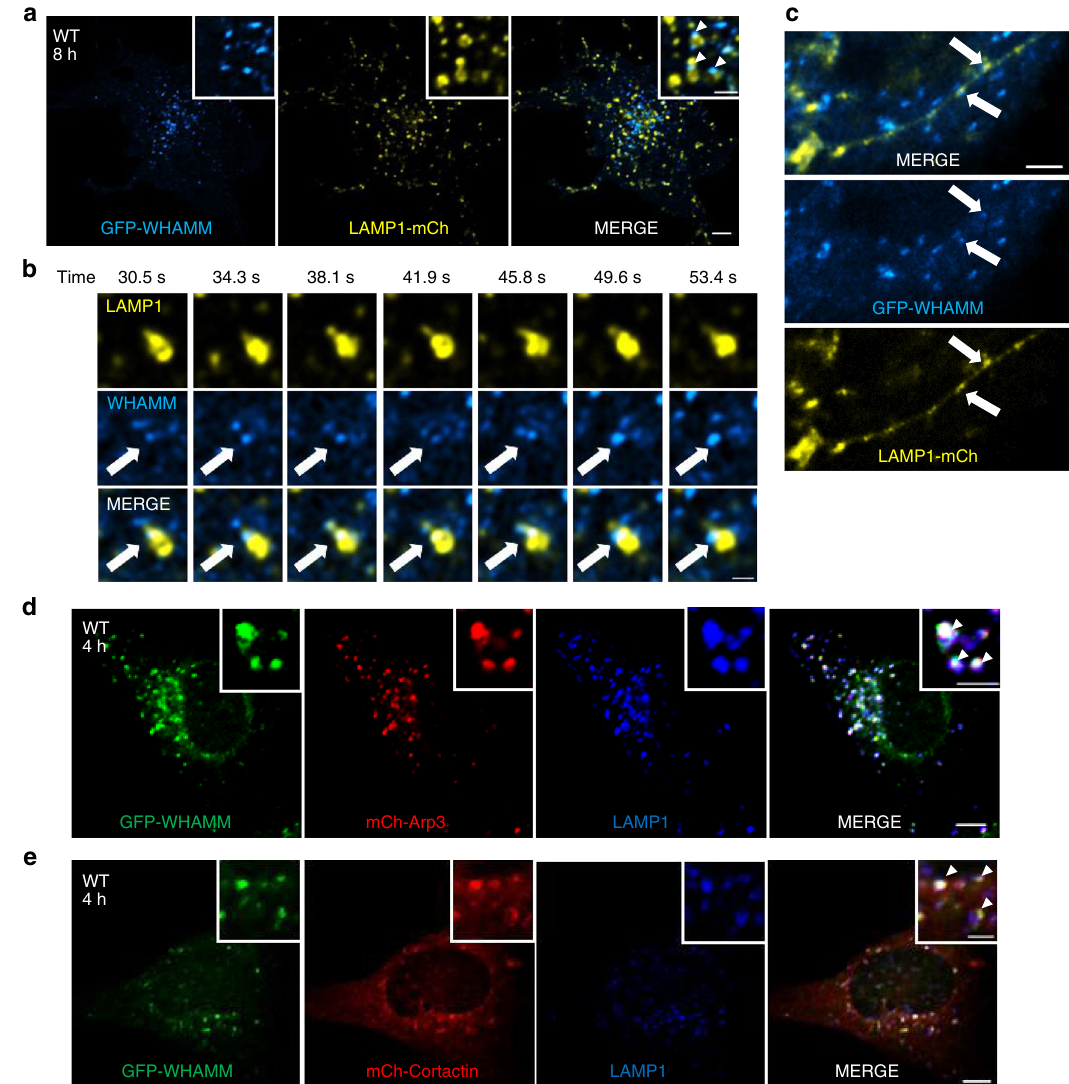
Fig. 4 WHAMM generates branched actin network on autolysosomes. a WT NRK cells stably expressing GFP-WHAMM were transfected with LAMP1- mCherry. 18 h post transfection, cells were starved for 8 h and observed using live-cell imaging. GFP-WHAMM was pseudo-colored to cyan and LAMP1- mCherry was pseudo-colored to yellow. Arrowheads indicate WHAMM puncta on the surface of autolysosomes (scale bar, main Fig. 5 μ m; upper right panel 2 μ m). b Time-lapse images were taken of cells in a . Arrows indicate WHAMM puncta at the neck of a newly formed reformation tubule on an autolysosome (scale bar, 2 μ m). c A snapshot of an elongated reformation tubule was extracted from cells in a . Arrows indicate WHAMM puncta on the reformation tubule. (Scale bar, 5 μ m). d , e WT NRK cells stably expressing GFP-WHAMM were transfected with mCherry-Arp3 and mCherry-Cortactin, respectively. In all, 18 h post transfection, cells were starved for 4 h and then fi xed and stained with antibody against LAMP1. Arrowheads indicate co- localization of WHAMM-Arp3 or WHAMM-Cortactin with autolysosomes (scale bar, main Fig. 5 μ m; upper right panel 2 μ m). All images in this fi gure were deconvolved using Nikon ’ s built-in software Correlative confocal and electron microscopy . Cells were seeded on a grid dish (Cellvis, D35-14-1.5GI) and initially fi xed in 4% paraformaldehyde (PFA), then observed by confocal microscopy. After the confocal micrographs were taken, cells were further fi xed in 2.5% glutaraldehyde (GA) for 2 h at RT. Cells were then dehydrated with a graded ethanol series (50%, 70%, 90%, 95%, and 100%) for 2 min each. Samples were in fi ltrated with and embedded in SPON12 resin, which was polymerized for 48h at 60°C. 70nm-thick ultrathin sections were cut using a diamond knife, and then picked up with Formvar-coated copper grids (100 mesh). The sections were double stained with uranyl acetate and lead citrate. After air drying, cells were observed using a Hitachi, H-7650B transmission electron microscope at an acceleration voltage of 80 kV.